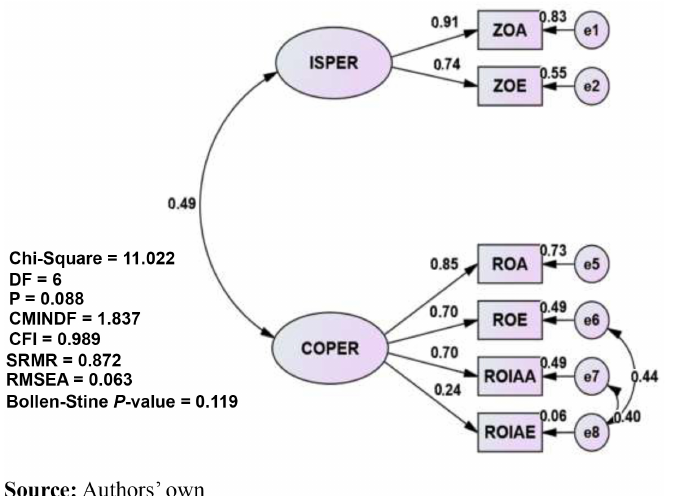
Figure 5. CFA model of